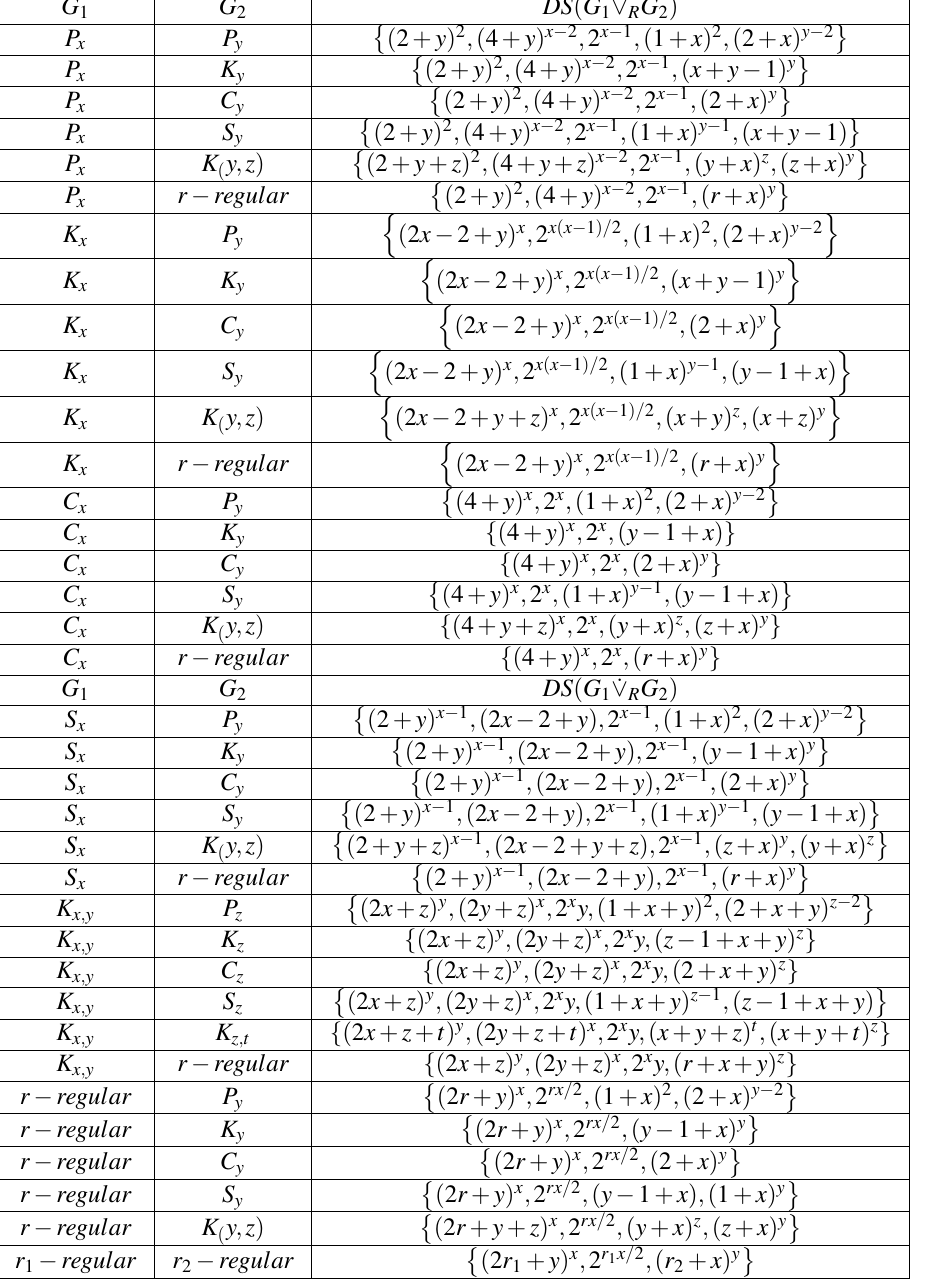
Table 3 Degree Sequence of vertex- R join graph for path, complete graph, cycle, star, complete bipartite and r − regular